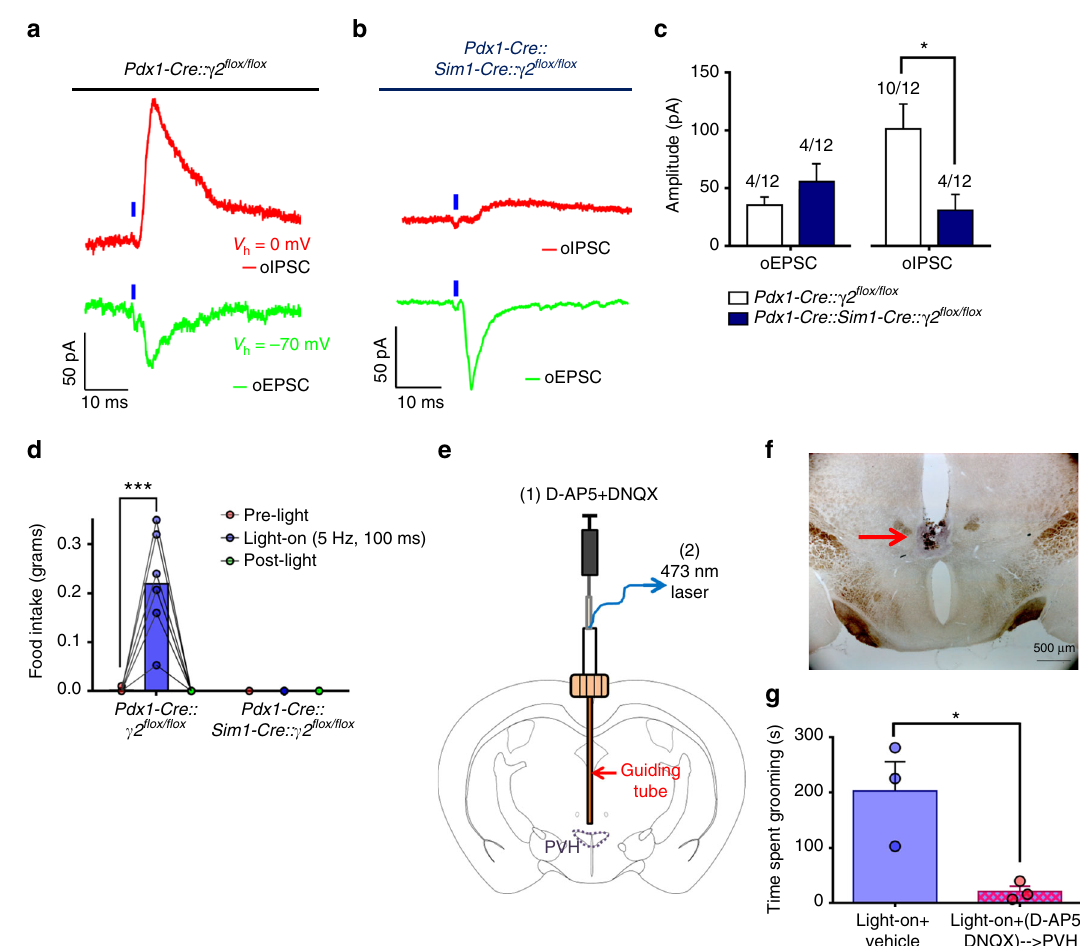
Fig. 4 GABA-A and ionotropic glutamate receptor activation in PVH are required for LH Pdx1-ChR2 → PVH evoked feeding and grooming, respectively. a Inhibitory (oIPSC, top) and excitatory (oEPSC, bottom) post-synaptic current responses evoked by 1-ms blue light pulse (blue tick) in a PVH neuron of